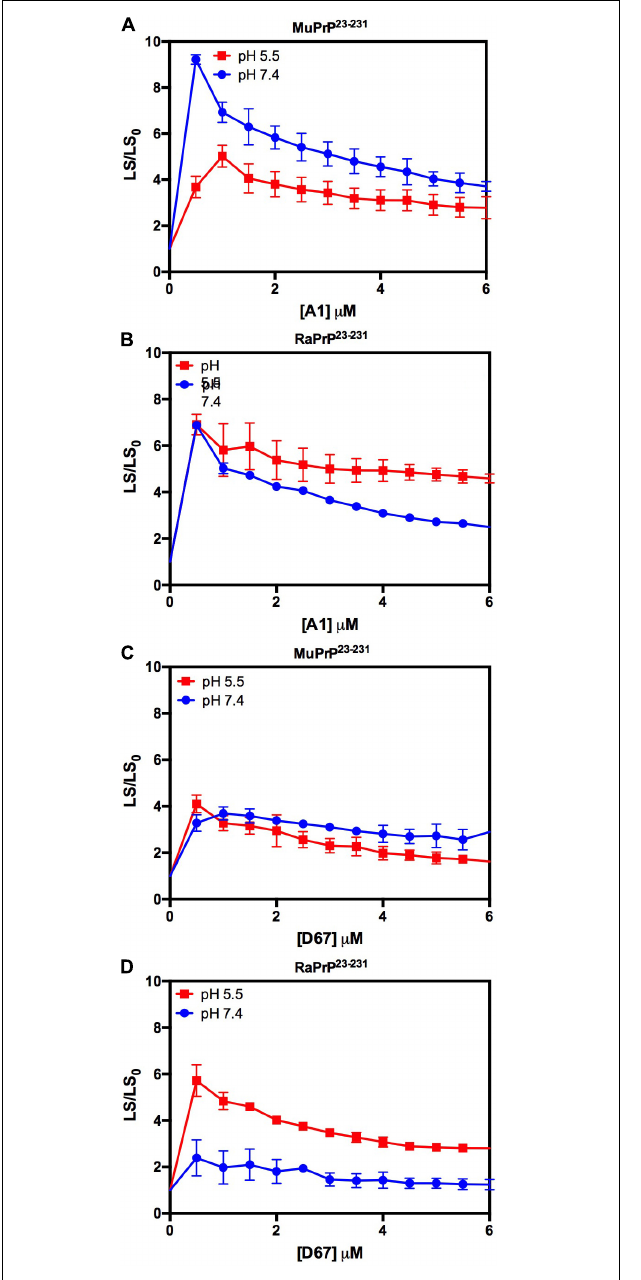
FIGURE 10 | Interaction of PrP 23 − 231 with DNA oligonucleotides causes an increase in light scattering. Effect of A1 (A,B) and D67 (C,D) on the relative light scattering of PrP 23 − 231 . Proteins used are MuPrP (A,C) and RaPrP (B,D) at pH 5.5 (red) and 7.4 (blue). The curves were performed with 2 µ M PrP 23 − 231 and increasing concentrations of oligonucleotides (from 0.5 to 6 µ M). The experiments were performed in 50 mM Tris buffer containing 100 mM NaCl at pH 7.4 or 20 mM sodium acetate buffer containing 100 mM NaCl at pH 5.5. All experiments were performed at 25 ◦ C. The error bars represent the standard deviation of at least two independent experiments. cofactor-mediated aggregation, as observed here. The interaction site of low molecular weight heparin in the globular region of PrP is close to HIS186 (Vieira et al., 2011). Rabbit PrP